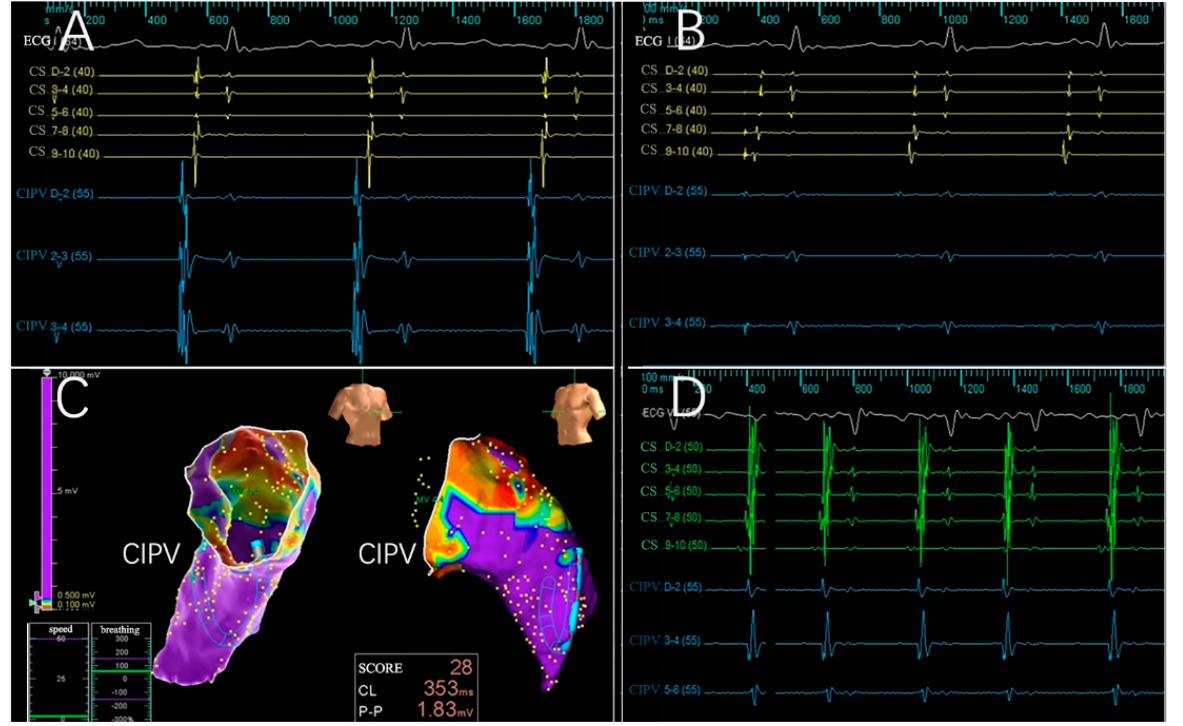
Figure 4. Electrophysiologic evaluation of the CIPV treatment with PFA. Electrograms for the CIPV were reduced, and after trains were delivered, only far-field signals remained. ( A , B ) Electrograms before and after PFA; complete electrical isolation was confirmed by the entrance block. ( C ) A chronic map demonstrating isolated CIPV. ( D ) A potential reduction was observed 4 weeks after PFA, showing a level of isolation in the CIPV. ECG:Electrocardiogram; CS: coronary vein sinus; CIPV: common inferior pulmonary vein.